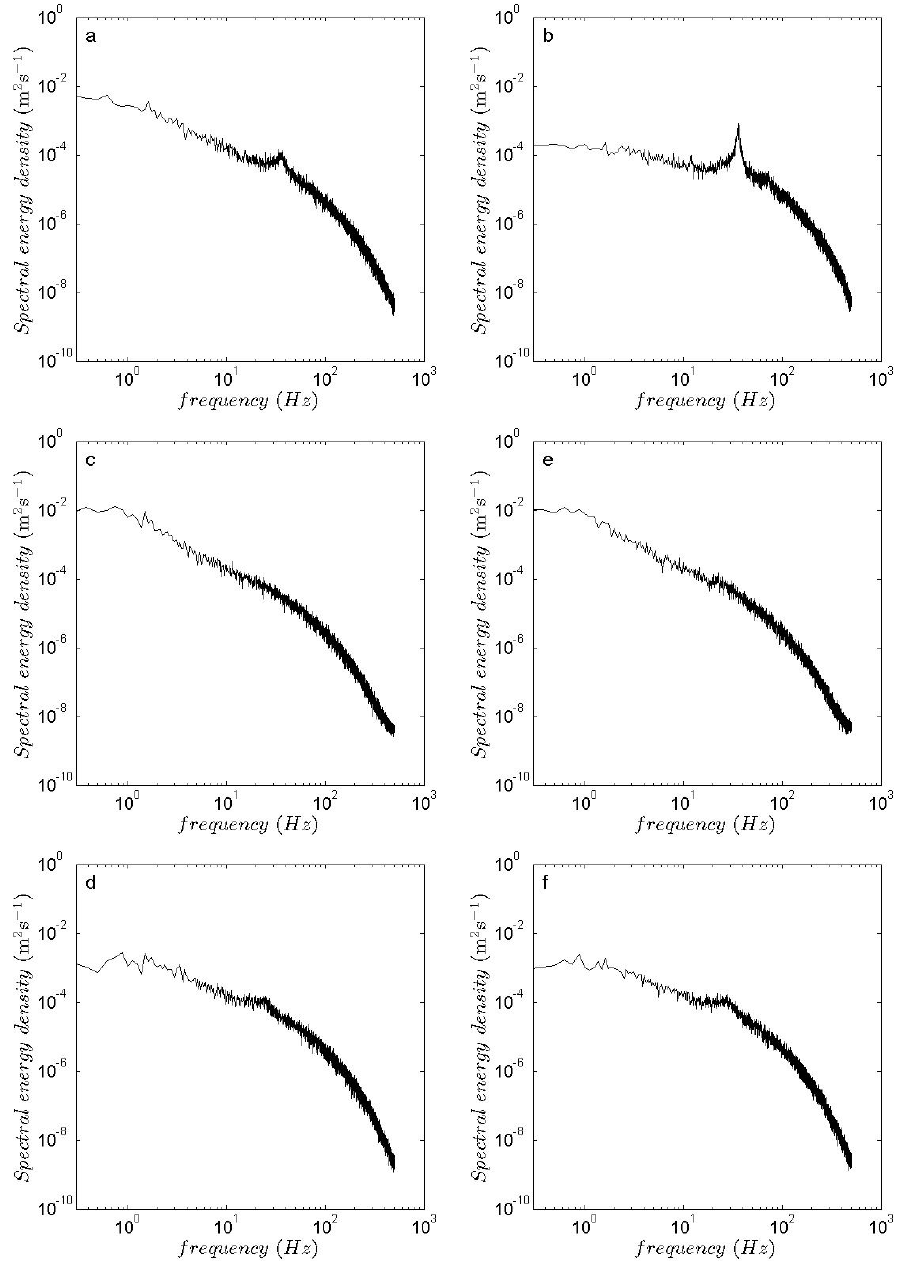
Figure 13. Power spectrum of the streamwise (u) and vertical (w) velocity components at top tip height inside the wind farm. ( a ) u-component at x/d = 1 behind the 1 st turbine ( S = 5); x ( b ) w-component at x/d = 1 behind the 1 st turbine; ( c ) u-component at x/d = 1 behind the 10 th turbine ( S = 5); ( d ) w-component at x/d = 1 behind the 10 th turbine ( S = 5); x x ( e ) u-component at x/d = 1 behind the 10 th turbine ( S = 7); ( f ) w-component at x/d = 1 x behind the 10 th turbine ( S = x